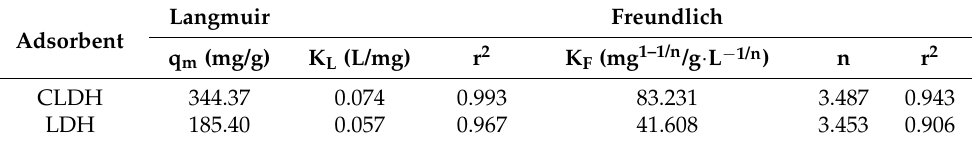
Figure 7. Experimental points and nonlinear fitted isotherm curves of PBV adsorption by ( a ) CLDH and ( b ) LDH: R = 0.1 g/L, agitation time = 2 h, initial pH = 5.62 and T = 25 °C. Table 4. Isotherm models constants calculated for PBV adsorption by Fresh and calcined LDH. Langmuir Adsorbent